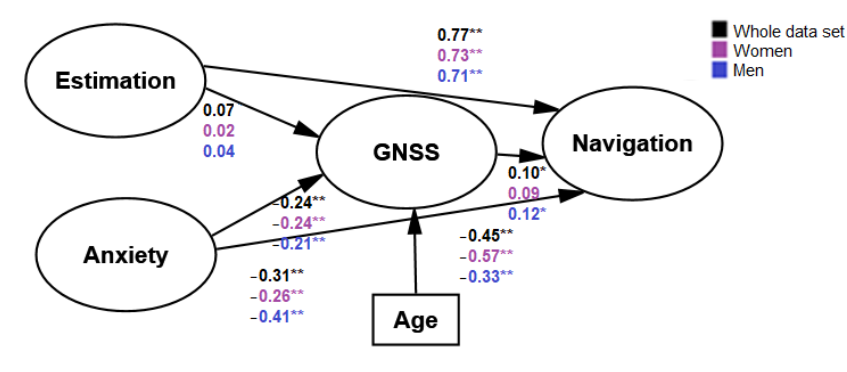
Figure 3. Estimation and loadings of the model proposed. ** = p < 0.001; * = p < 0.05. The goodness of fit for the women group was found: χ 2 / degrees of freedom = 2.19; NFI = 0.793; IFI = 0.876; CFI = 0.874; RMSEA = 0.08. The goodness of fit for the men group was found: χ 2 / degrees of freedom = 2.09; NFI = 0.77; IFI = 0.866; CFI = 0.864; RMSEA = 0.08. With regard to the PLS approach, Figure 4 shows the inherent path for each group and the whole data set.